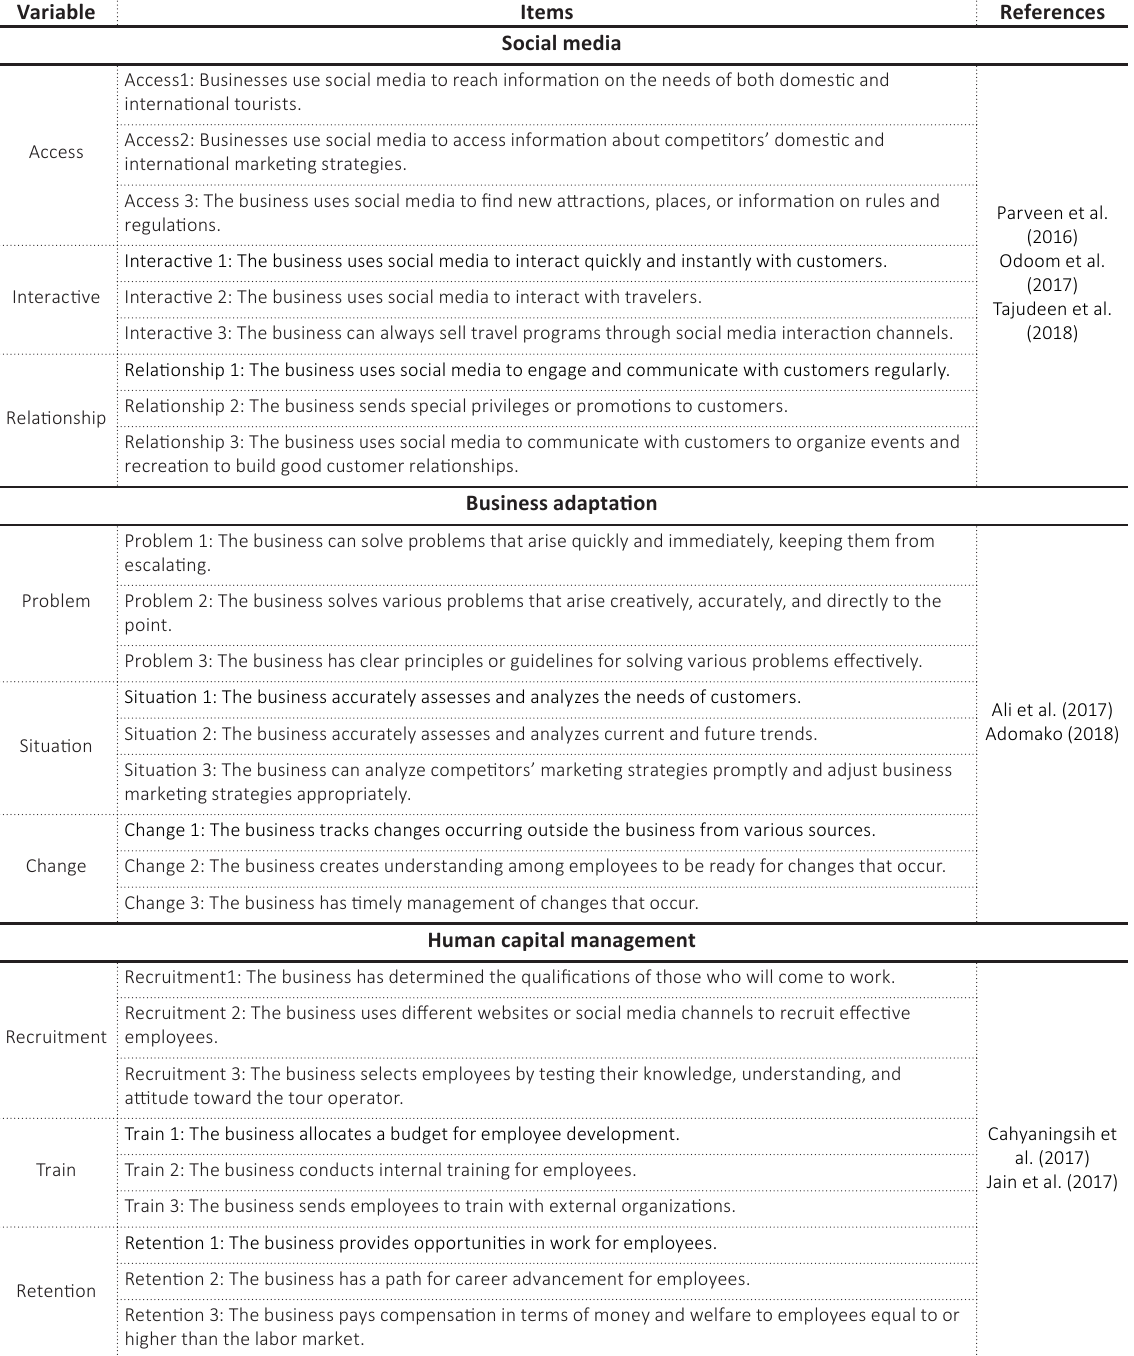
Table 1 (cont.). Research measurement